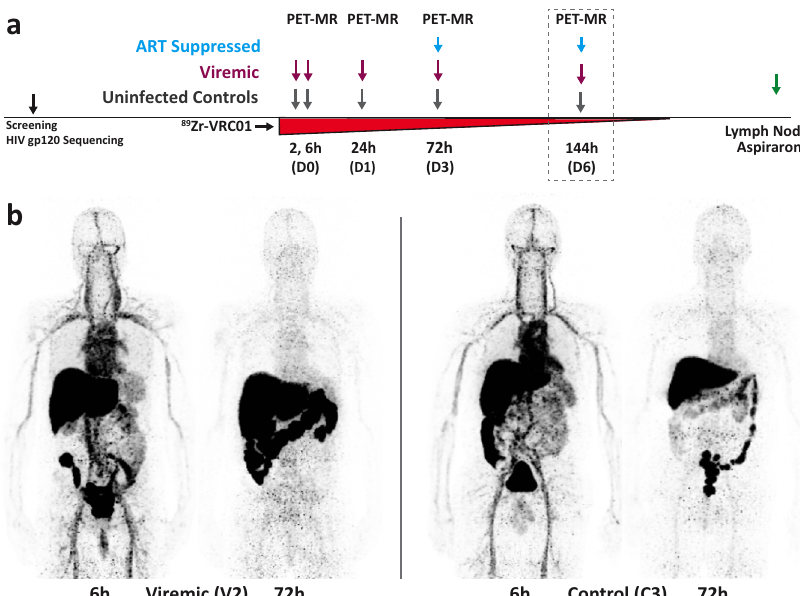
Fig. 1 First-in-human immunoPET imaging of HIV persistence. A schematic of PET-MR imaging work fl ow including tracer administration and imaging time points is shown in a . Imaging on day 6 was limited to a subset of participants to determine if meaningful information could be obtained over longer periods of time various tissues of interest. Representative 3-dimensional maximum intensity projection images (MR attenuation corrected, but without MR overlay) of 89 Zr-VRC01 uptake 6 and 72 h in a viremic (V2) and uninfected control (C3) participant are shown ( b